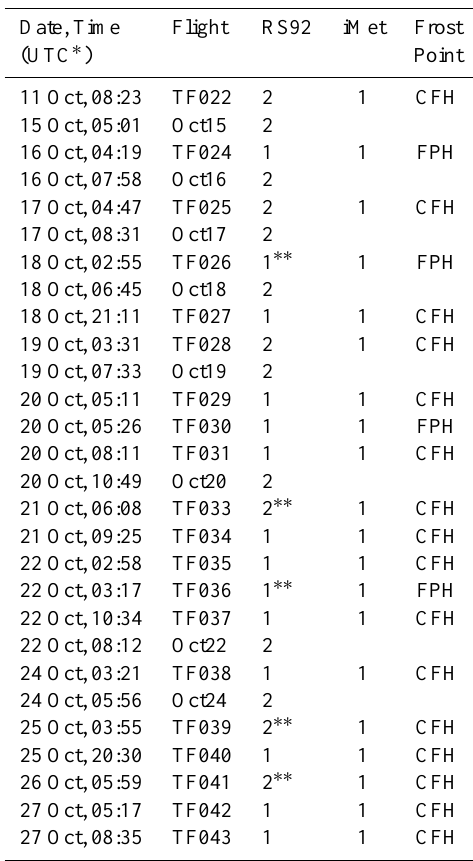
Table 1. Balloon launches and